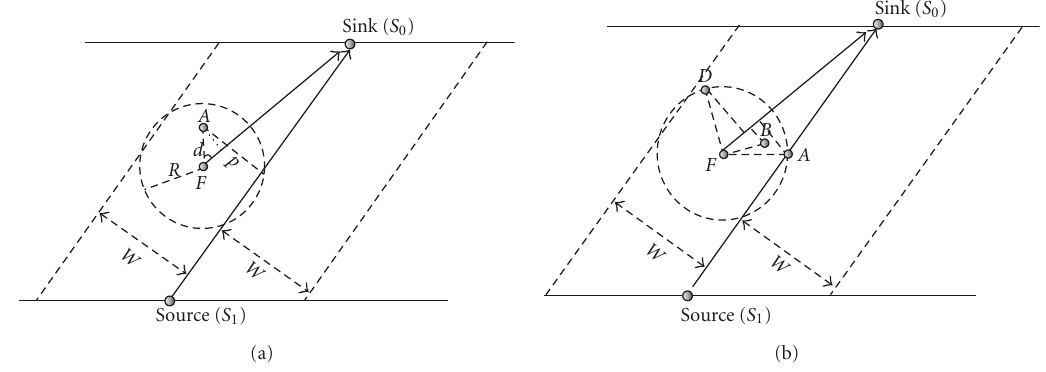
Figure 2: VBF illustration: (a) Desirableness Factor; (b) VBF with